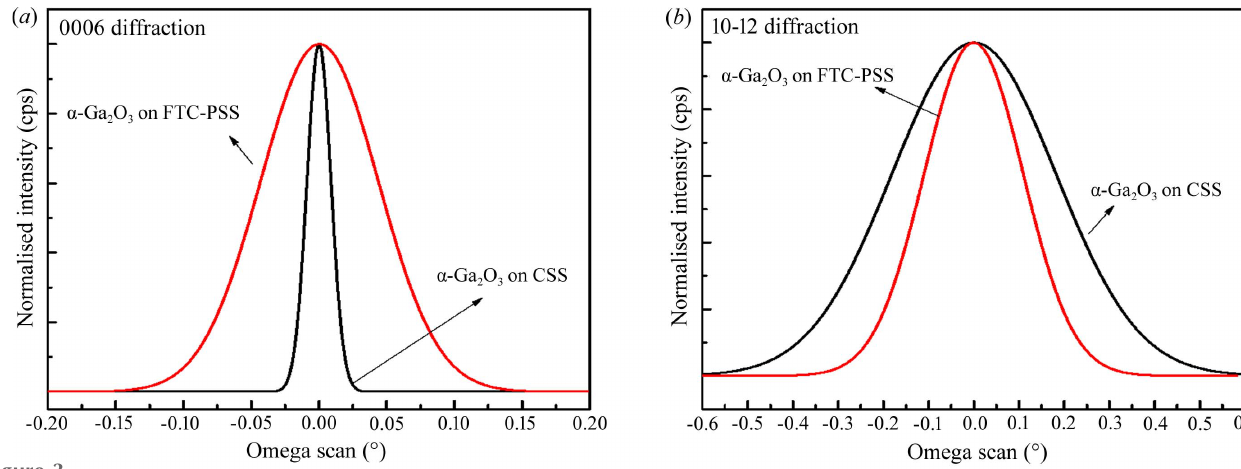
Figure 3 X-ray omega rocking curves of the (cid:2) -Ga 2 O 3 epilayers grown on CSS and CF-PSS; ( a ) 0006 diffraction and ( b ) 10–12